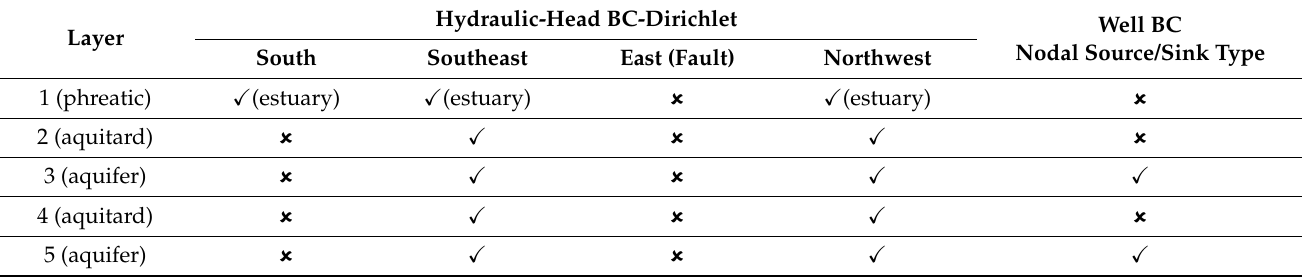
Figure 7. Groundwater flow model and calibration values. Table 2. Boundary conditions applied in the numerical model; BC is Boundary Condition; means not applied; is applied. Table 3. Minimum and maximum flowrates for the wells and comparison between the hydraulic gradients and groundwater flow direction, used for delimitation of the actual WPAs (2011), and data from 2020.